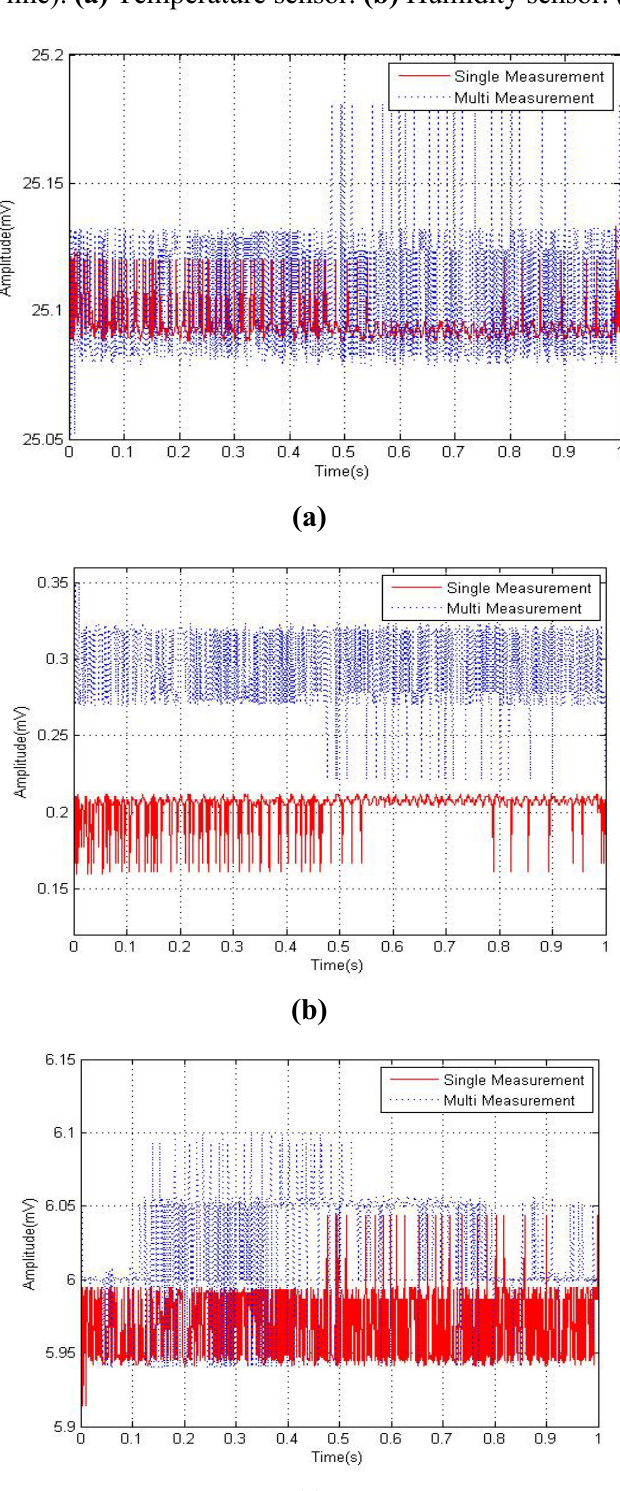
Figure 2. Compare sensor data between the single (solid line) and multi-sensing environment (dotted line). (a) Temperature sensor. (b) Humidity sensor. (c) Oxygen